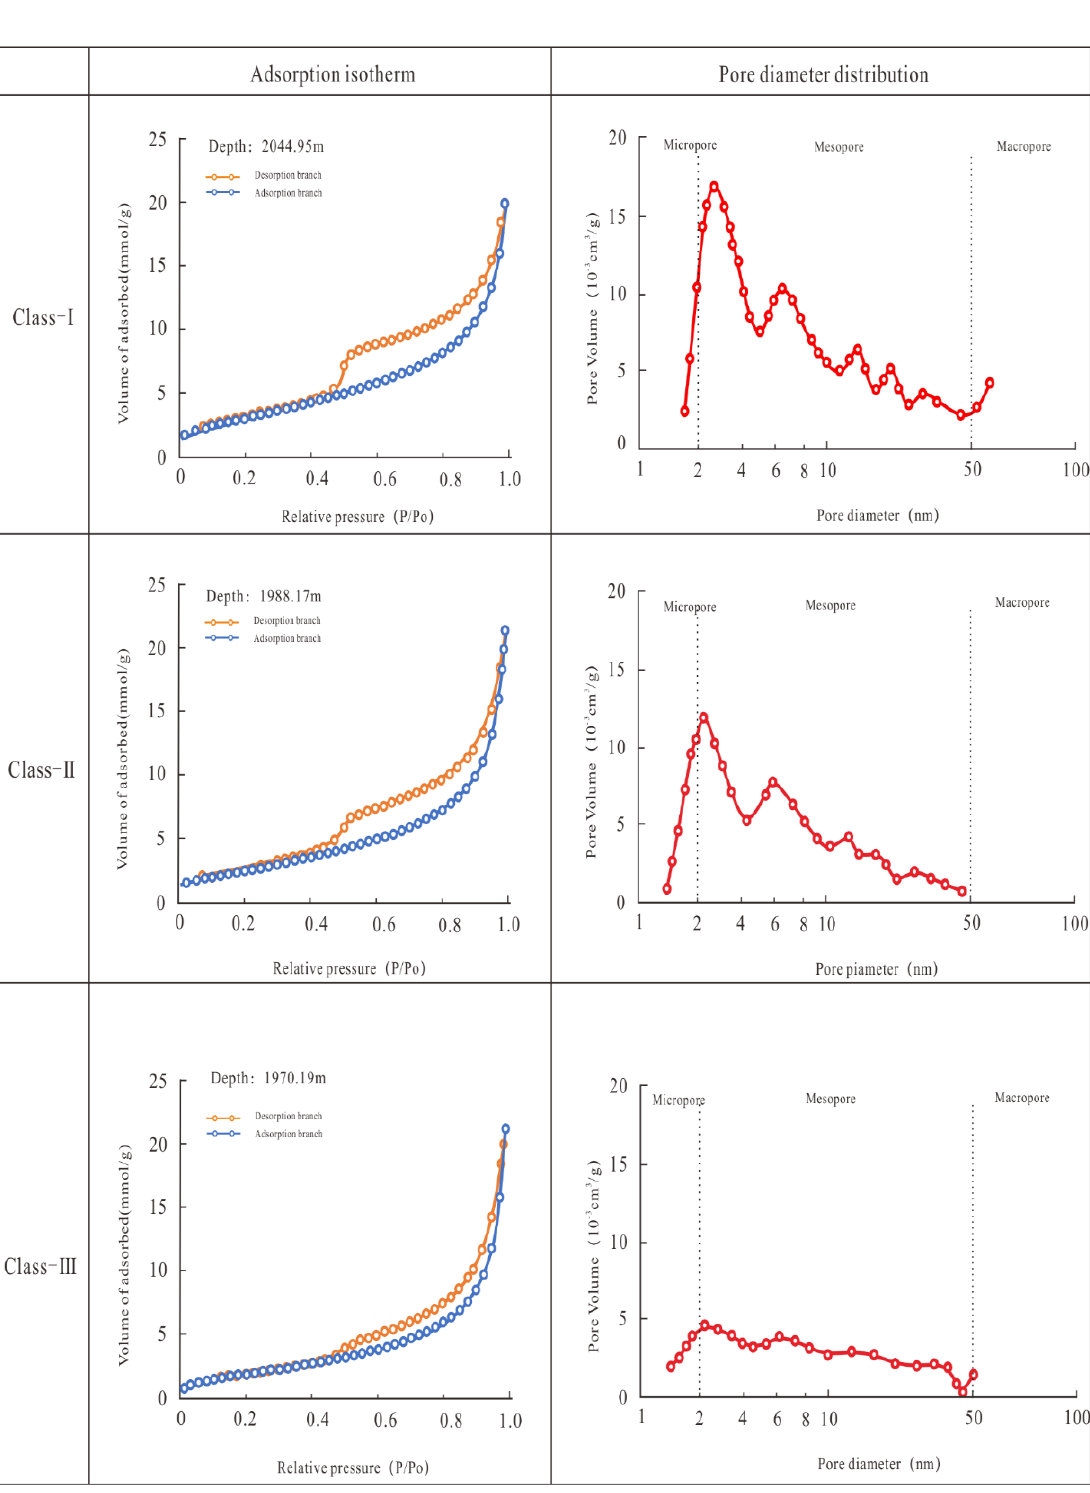
Figure 5. Pore diameter distribution of typical shale samples from K 2 qn 1 Member, Da’an area, Songliao Basin.